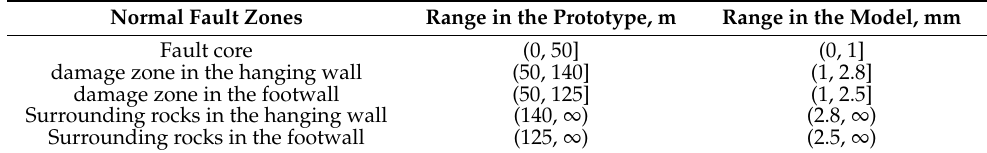
Figure 19. Schematic diagram of the five regions of a normal fault.